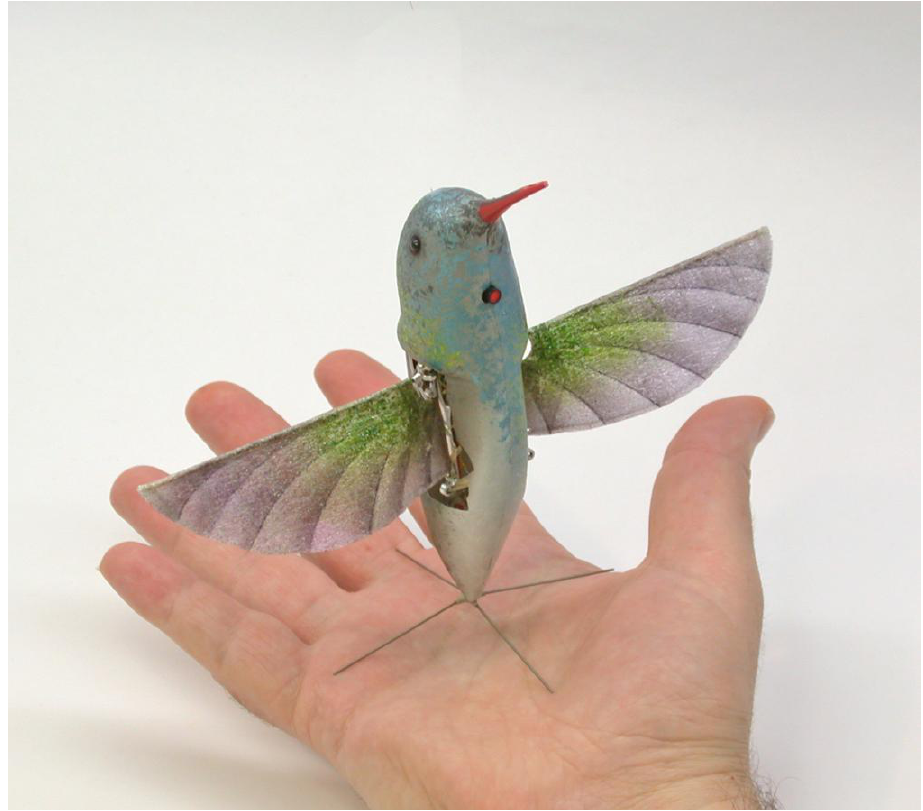
Figure 2. Courtesy AeroVironment, Inc.